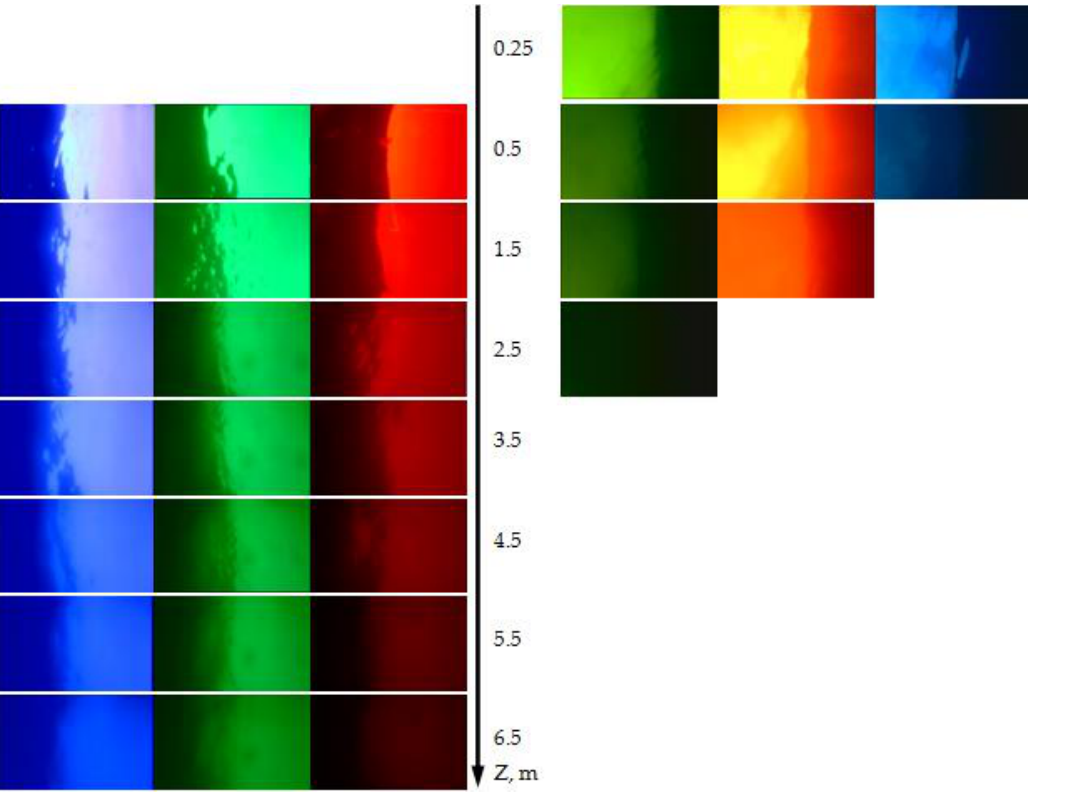
 :    marked by shaded area in Figure 5. The 1 2